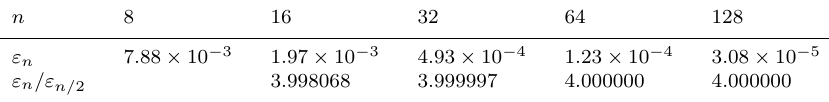
Table 2. Numerical results for f ( x ) = x 2 , x ∈ [ − 1 , 1] , uniform mesh, n even. n 8